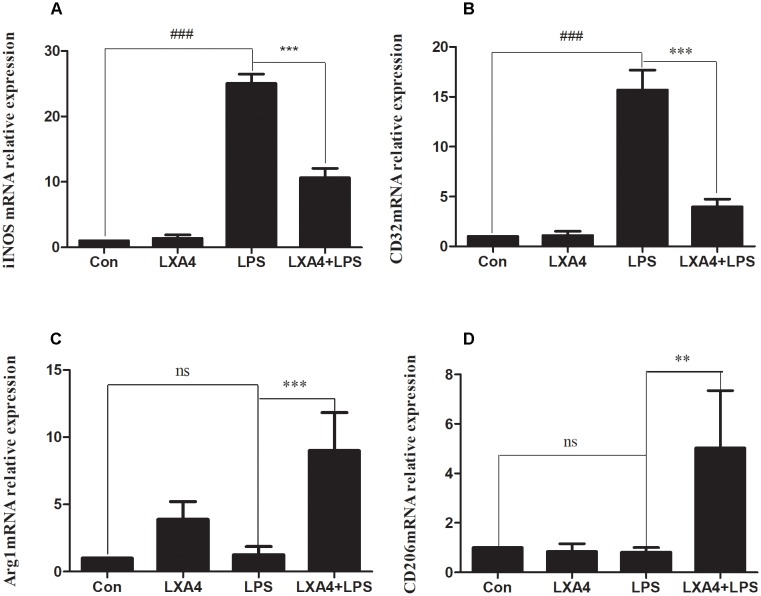
Quantitative RT-PCR analysis of iNOS, CD32, Arg1, CD206 mRNA levels in the BV2microglia 6 h after LPS treatment. (A,B) Quantitative RT-PCR analysis of iNOS, CD32 mRNA levels. (C,D) Quantitative RT-PCR analysis of Arg1, CD206 mRNA levels. LPS upregluated M1 microglia biomarkers iNOS, CD32. With LXA4 intervention, iNOS, CD32 expression decreased, M2 microglia biomarkers Arg1, CD206 expression increased significantly. ##,∗∗p < 0.01; ###,∗∗∗p < 0.001; n.s., no significance.